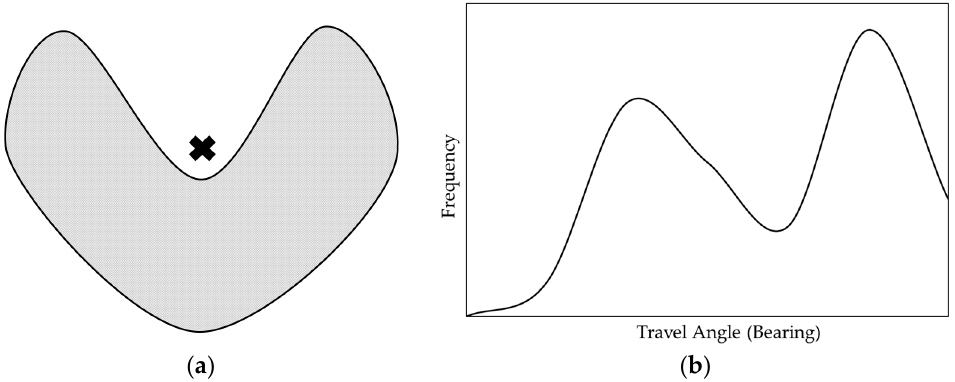
Figure 6. The criteria indicating splitting of a debris-flow cluster: ( a ) the centroid of the debris-flow cluster is outside the boundary of the debris-flow cluster, and ( b ) plotting the frequency distribution of the travel direction of debris-flow particles shows two distinct peaks in the first panel.